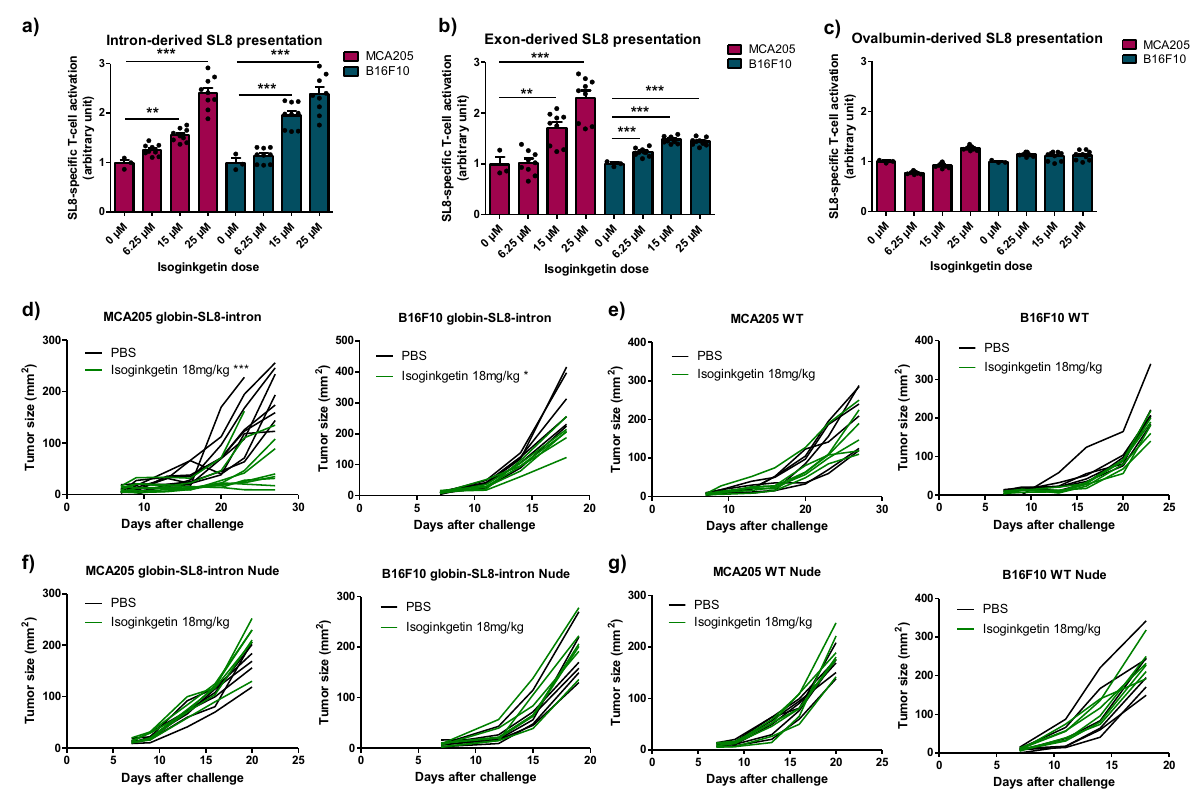
Fig. 1 Isoginkgetin increases exon- and intron-derived SL8 presentation in cancer cells in vitro and inhibits the growth of SL8-expressing tumors in vivo in an immune-dependent manner. SL8-speci fi c B3Z T-cell activation after co-culture with murine MCA205 fi brosarcoma and B16F10 melanoma both transiently expressing ( a ) the intron-derived SL8 epitope, ( b ) the exon-derived SL8 epitope, or ( c ) the OVA cDNA construct and treated for 18 h with isoginkgetin at indicated doses. Unspeci fi c B3Z T-cell activation was considered to normalize the results. Data are means ± SEM of relative B3Z T-cell activation for at least three biological replicates. d Individual tumor growth kinetics of MCA205 fi brosarcoma (left panel) and B16F10 melanoma (right panel) both stably expressing the globin-SL8-intron construct and ( e ) MCA205 fi brosarcoma WT (left panel) and B16F10 melanoma WT (right panel) subcutaneously inoculated into the right fl ank of immunocompetent C57BL/6 mice thereafter treated intraperitoneally with 18 mg/kg of isoginkgetin at days 5, 10, and 15. f Individual tumor growth kinetics of MCA205 fi brosarcoma (left panel) and B16F10 melanoma (right panel) both stably expressing the globin-SL8-intron construct and ( g ) MCA205 fi brosarcoma WT (left panel) and B16F10 melanoma WT (right panel) subcutaneously inoculated into the right fl ank of immunode fi cient nude mice thereafter treated intraperitoneally with 18 mg/kg of isoginkgetin at days 5, 10, and 15. ** P < 0.01, *** P < 0.001 (One-way ANOVA ( a – c ) and Student t -test ( d – g